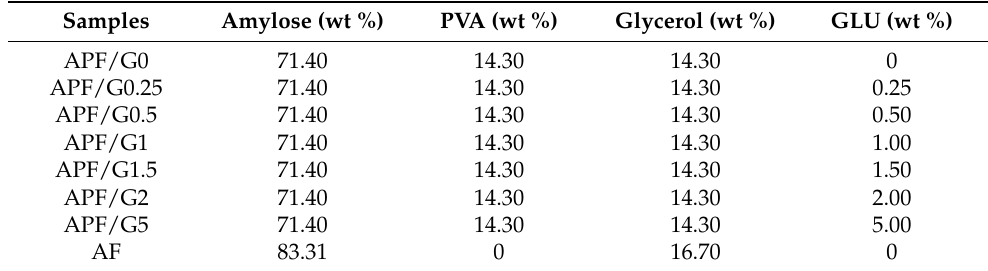
Table 1. Compositions of amylose/PVA blend